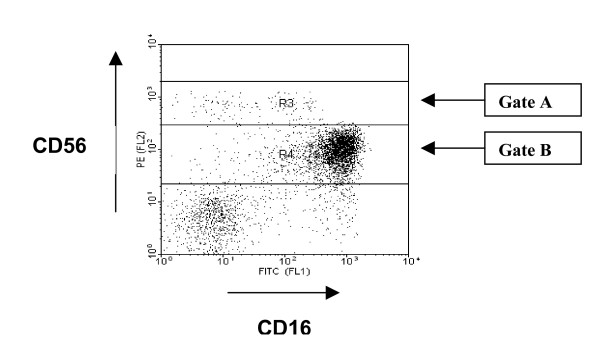
Identification of CD56bright and CD56dim NK cells. Peripheral blood lymphocytes were stained with CD3, CD56 and CD16 mABs and analysed. The CD3negative lymphocyte population was initially gated and then analysed for CD56 and CD16 expression. Gates A and B allow enumeration of the CD56bright and CD56dim NK cell population respectively.